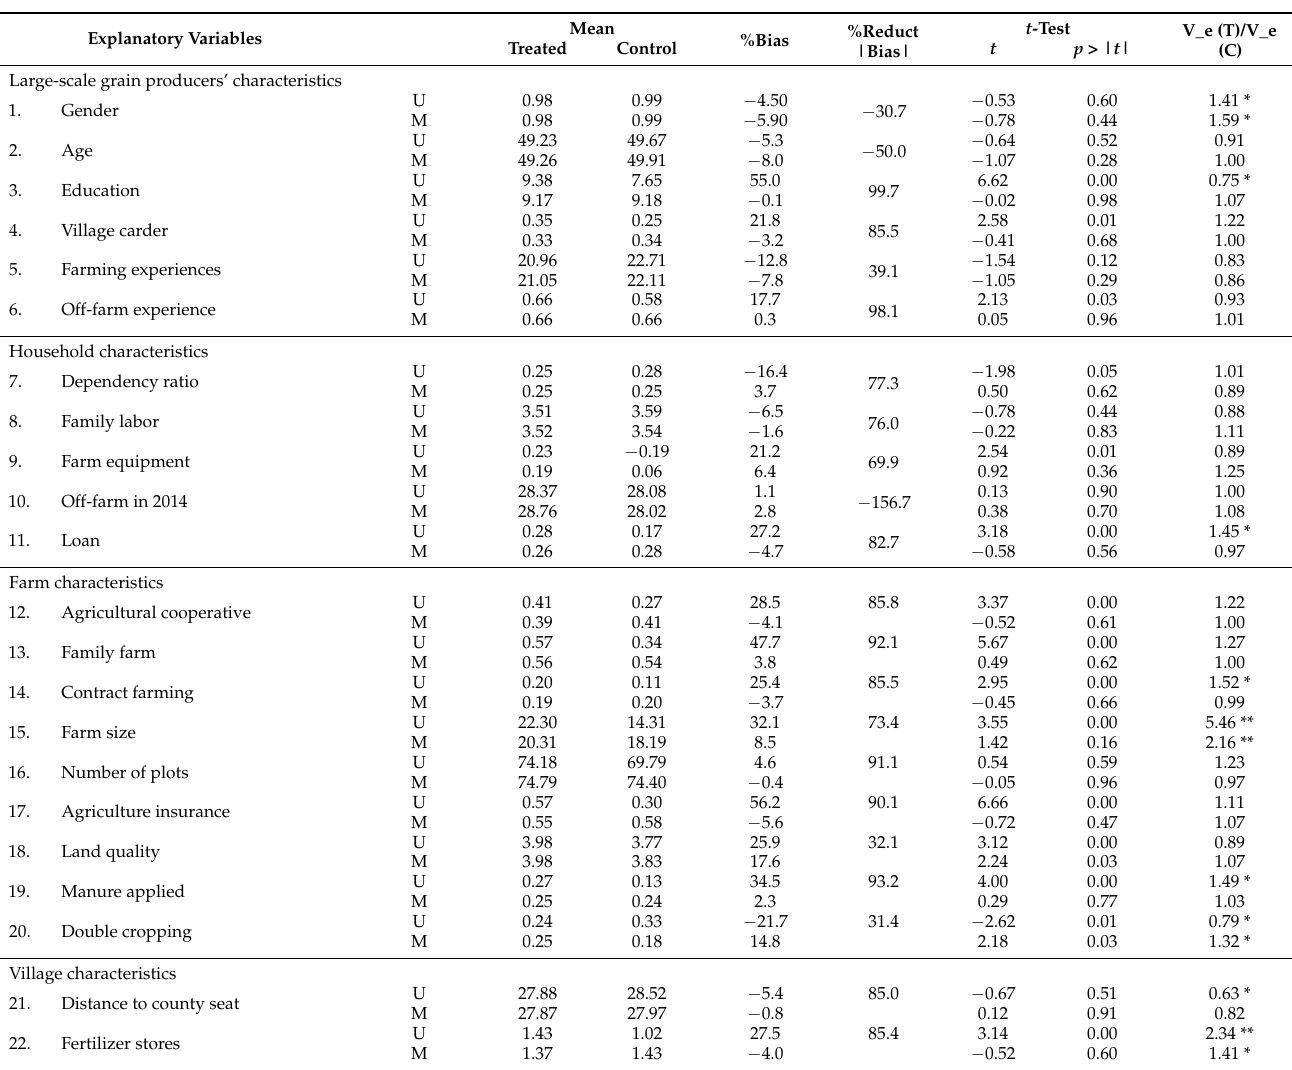
Table 5. Matching results of extension contact on large-scale farmers’ rice